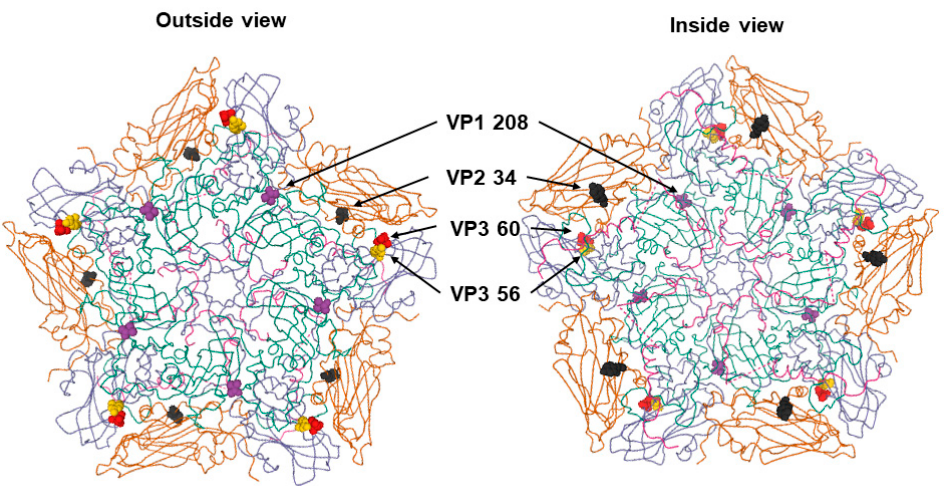
Figure 2. Relative locations of the mutated amino acid residues found in the cell-adapted O/SKR/Andong/2010 virus on the three-dimensional structural model of the foot-and-mouth disease virus (FMDV) serotype O pentamer. The positions of mutated amino acid residues of the cell-adapted virus (L5B6S2), including VP1 208 (purple), VP2 34 (black), VP3 56 (yellow), and VP3 60 (red) are indicated in the outer and inner schematic views of a pentameric subunit (O PanAsia, PDB accession no. 5NE4). The protein subunits of VP1, VP2, VP3, and VP4 are colored cyan, yellow, violet, and pink, respectively.